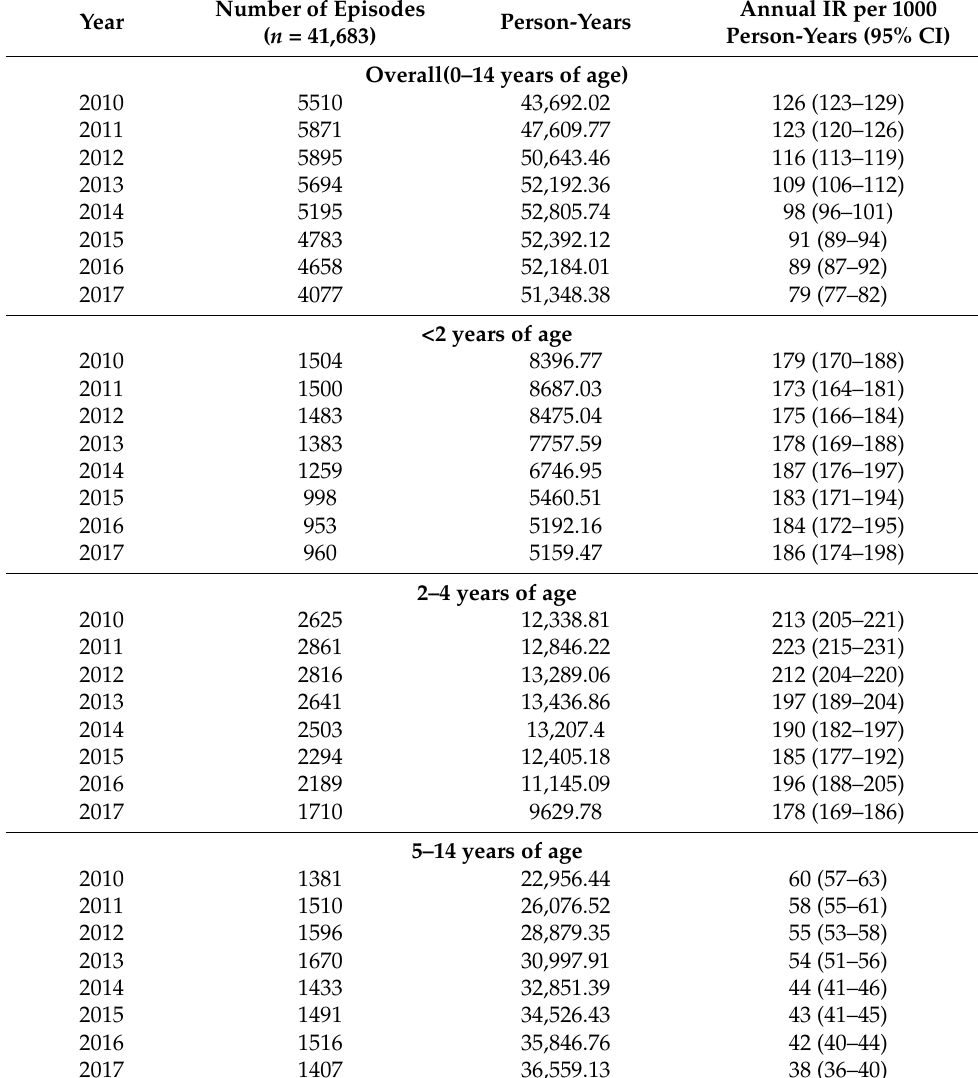
Table 1. Annual IR of AOM in the overall pediatric population 0–14 years of age and by age group. Number of Episodes Year ( n =